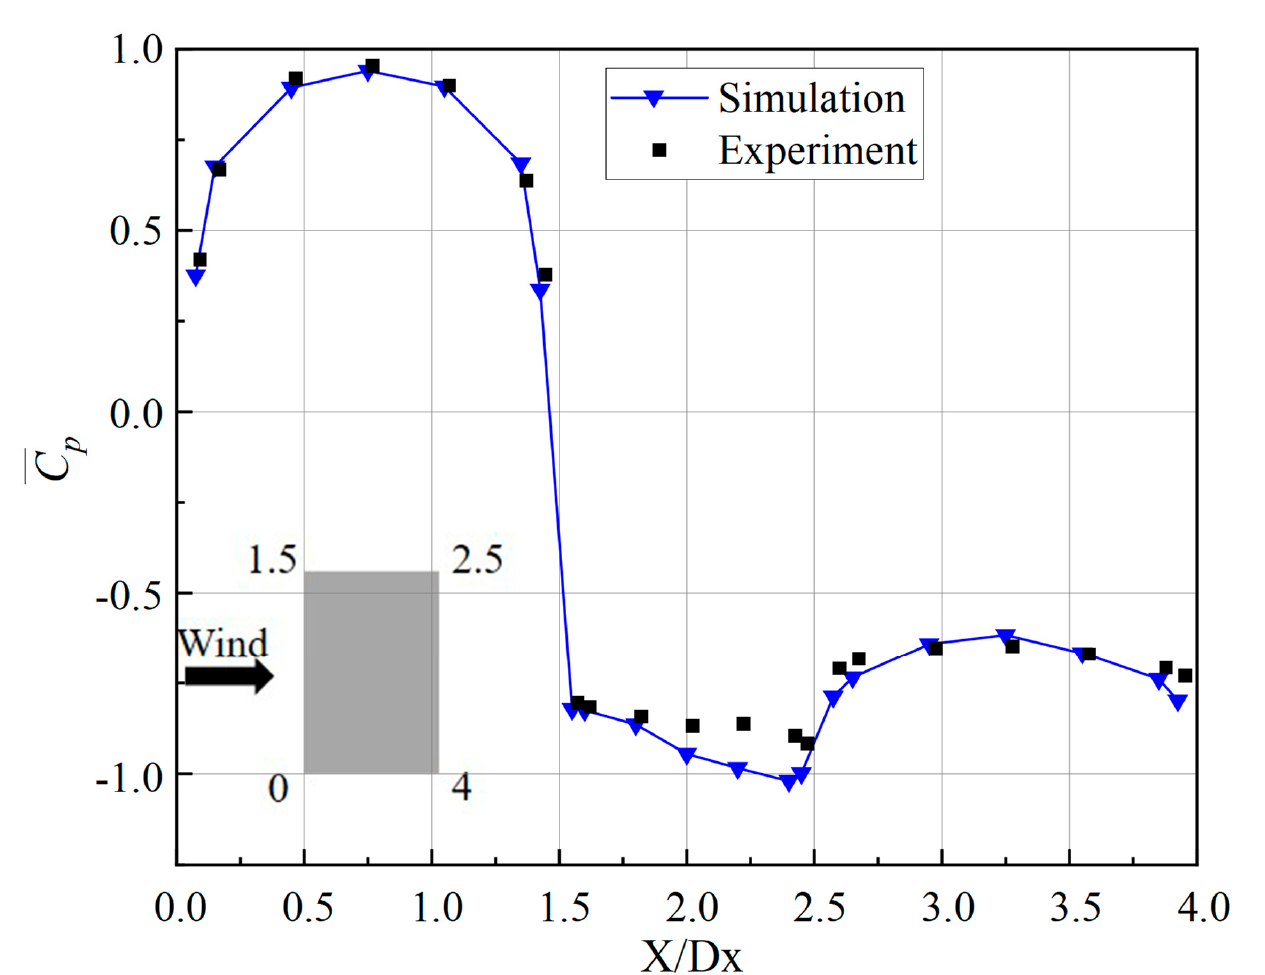
Figure 15. Comparison of mean pressure coefficients at 2/3 H of the CAARC model.